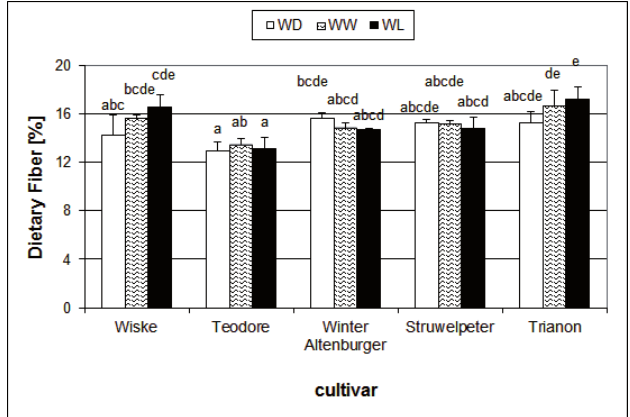
Fig. 5: Dietary Fiber [%] of different cultivars and varieties of Lactuca sativa spp. grown under different water regimes (water-deficit = 18- 25 % [WD], well-watered = 50 % [WW], water-logged = 61-70 % [WL]). Data represent n ± SD. Bars with different letters were sig- nificantly different (Dunett’s T3 test, p ≤ 0.05).